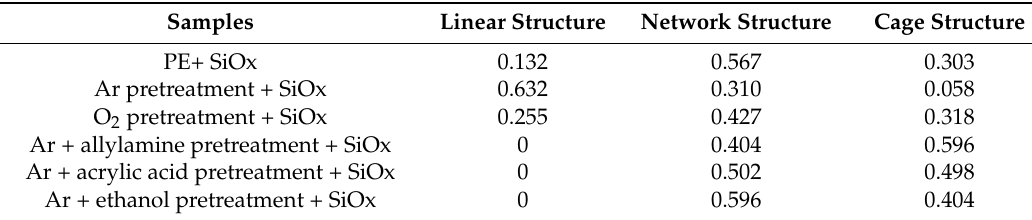
Table 1. The ratio of deconvoluted Si–O–Si in three peaks at 1023 cm − 1 , 1063 cm − 1 and 1135 cm − 1 for linear, network and cage micro-structures, respectively. Samples Linear Structure Network Structure Cage